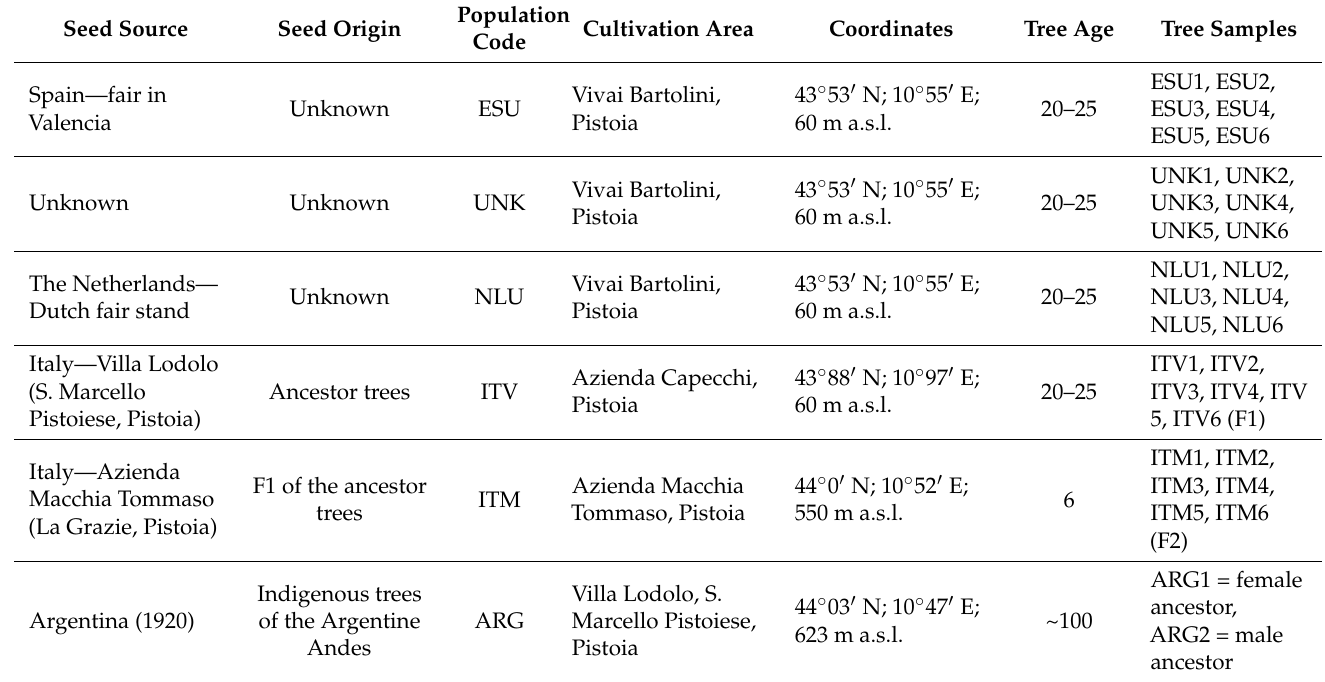
Table 1. Putative populations of A. araucana found in northern Tuscany (Italy): seed source, seed origin, population code, cultivation area and coordinates, tree age and codes of the tree